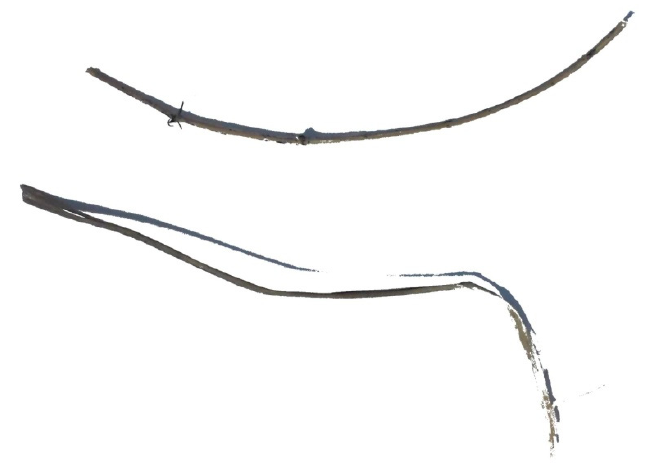
Figure 2. Image of grass elements: stem ( top ) and leaf blades ( bottom ).